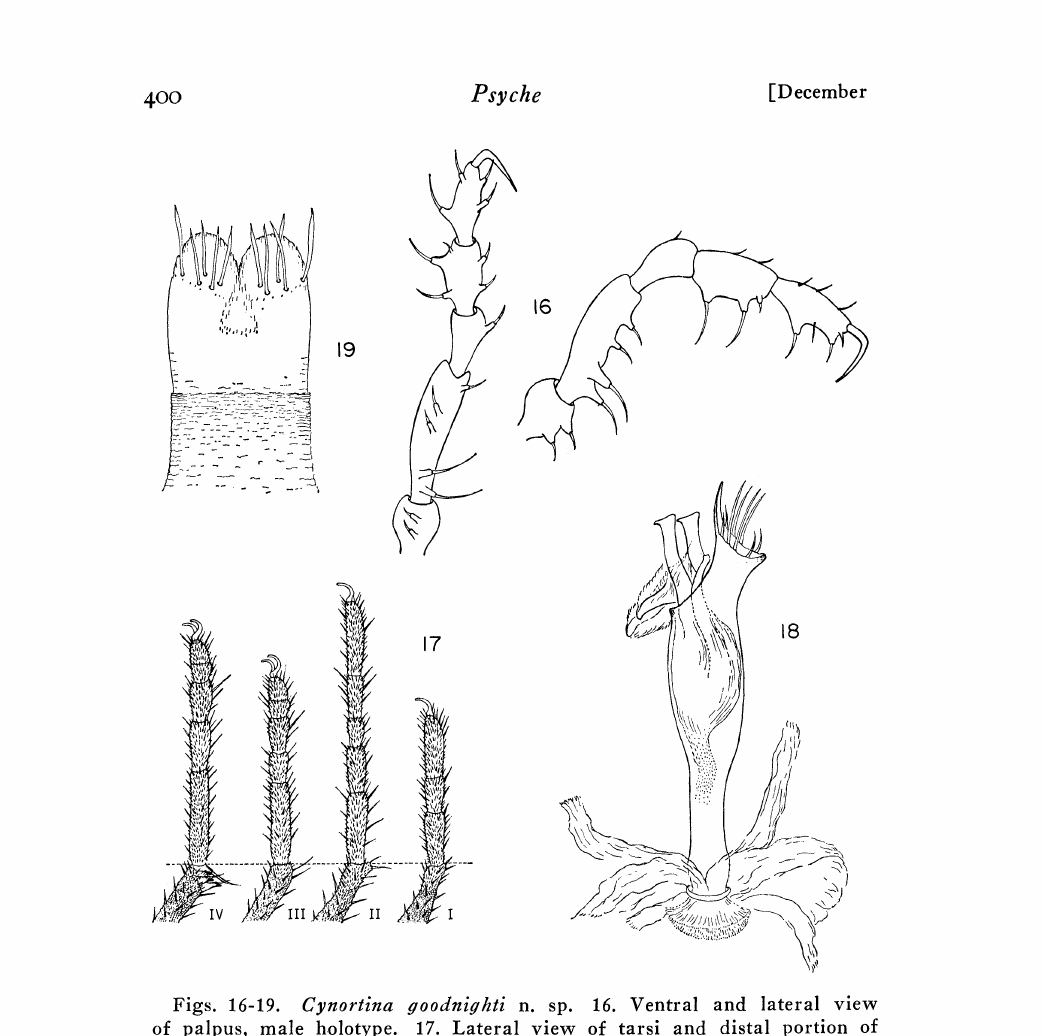
Figs. 16-19. Cynortina goodnighti n. sp. 16. Ventral and lateral view of palpus, male holotype. 17. Lateral view of tarsi and distal portion of metatarsi, male holotype. 18. Lateral view of penis. 19. Ventral view of ovipositor. tions on legs terminate abruptly at calcanea of metatarsi.